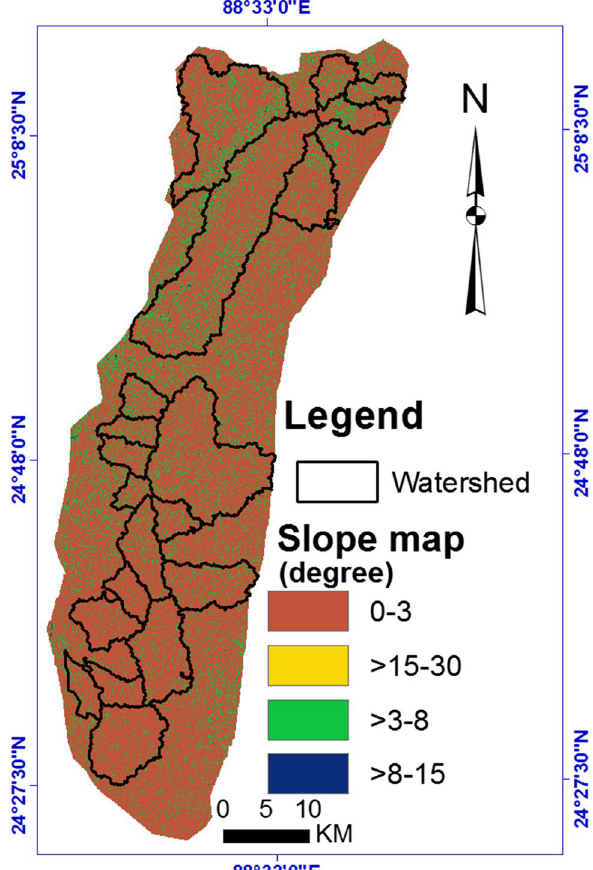
Fig. 3 Land use map of the proposed